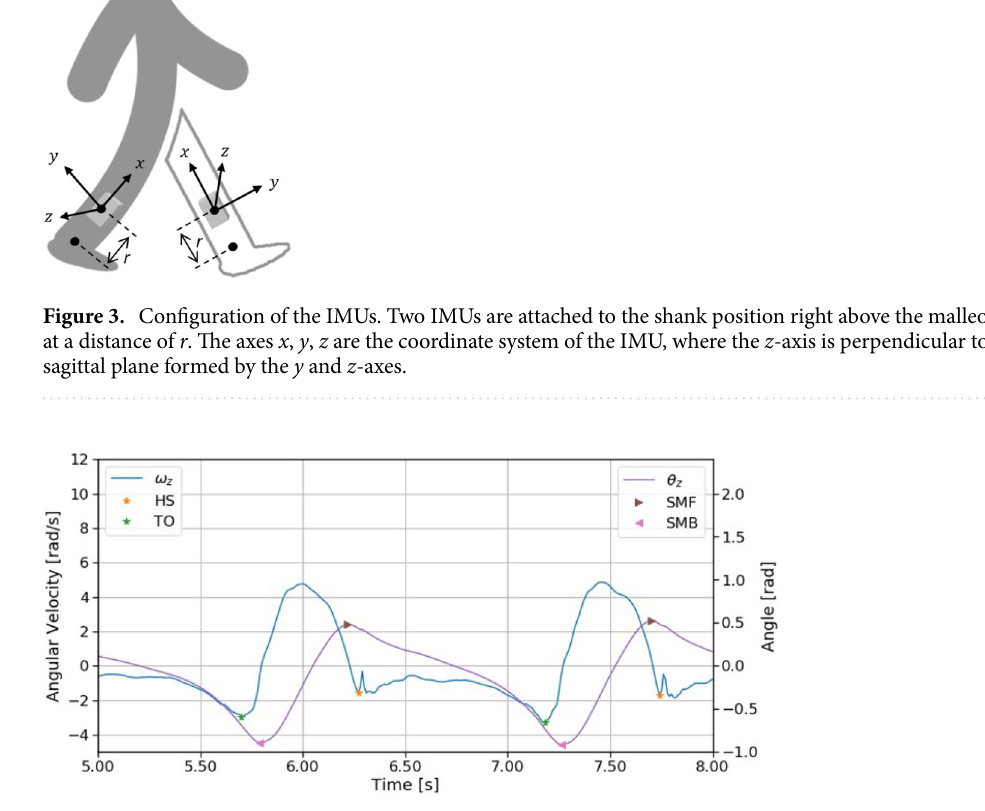
Figure 4. Samples of angular velocity, angle in the sagittal plane, and gait events. The heel-strike (HS) and toe- off (TO) events were defected from the angular